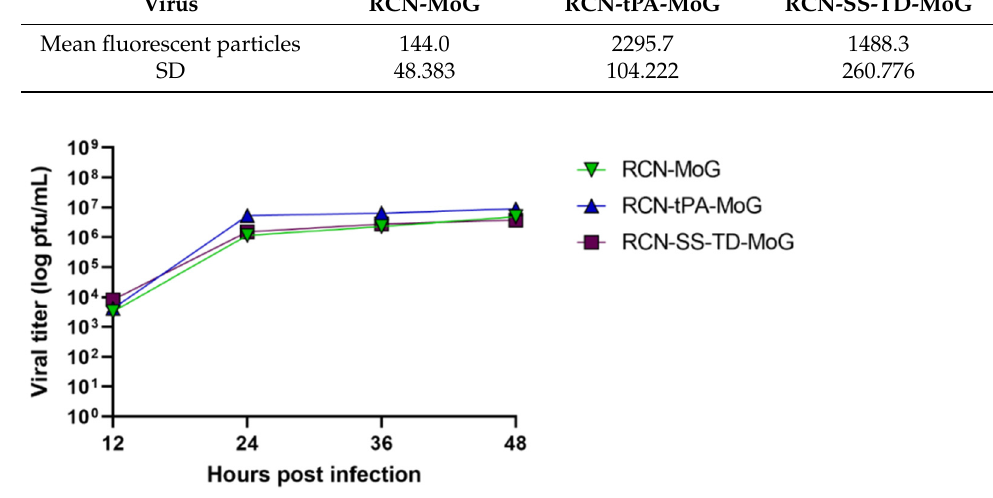
Figure 3. One-step growth curves for recombinant RCN constructs. Vero cells were infected with RCN-MoG, RCN-tPA-MoG, and RCN-SS-TD-MoG, collected at the indicated time points, and quanti- fied with a plaque assay.